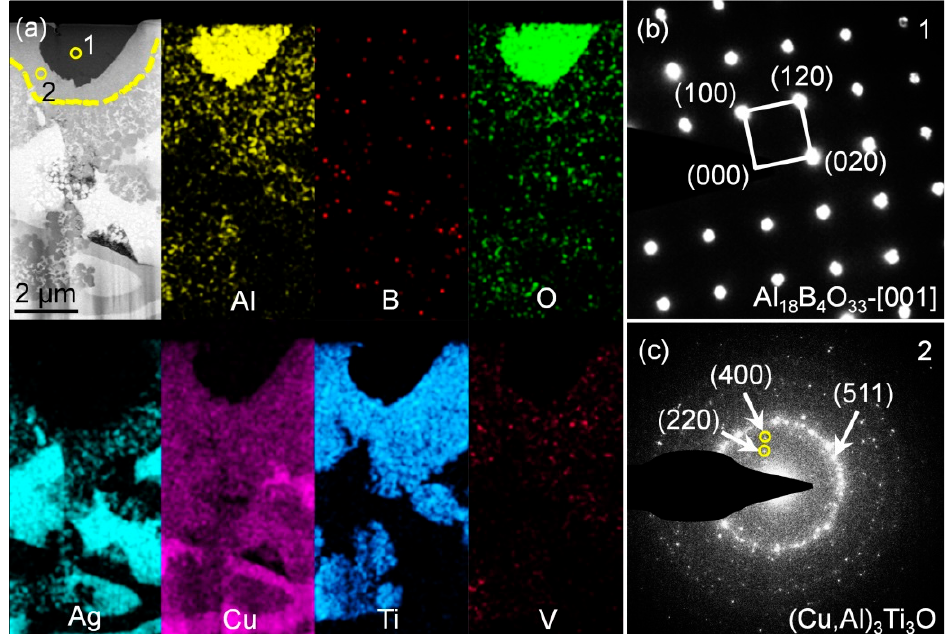
Figure 4. TEM characterization of the whisker-reinforced brazing seam obtained at 825 °C for 10 min. ( a ) STEM image and the EDS mapping results of the whisker/Ag-based alloy interface. ( b , c ) SAED patterns of the Al 18 B 4 O 33 whisker and the (Cu,Al) 3 Ti 3 O reaction layer, respectively.